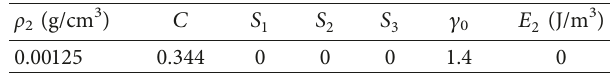
Table 2: Material parameters of air [22].